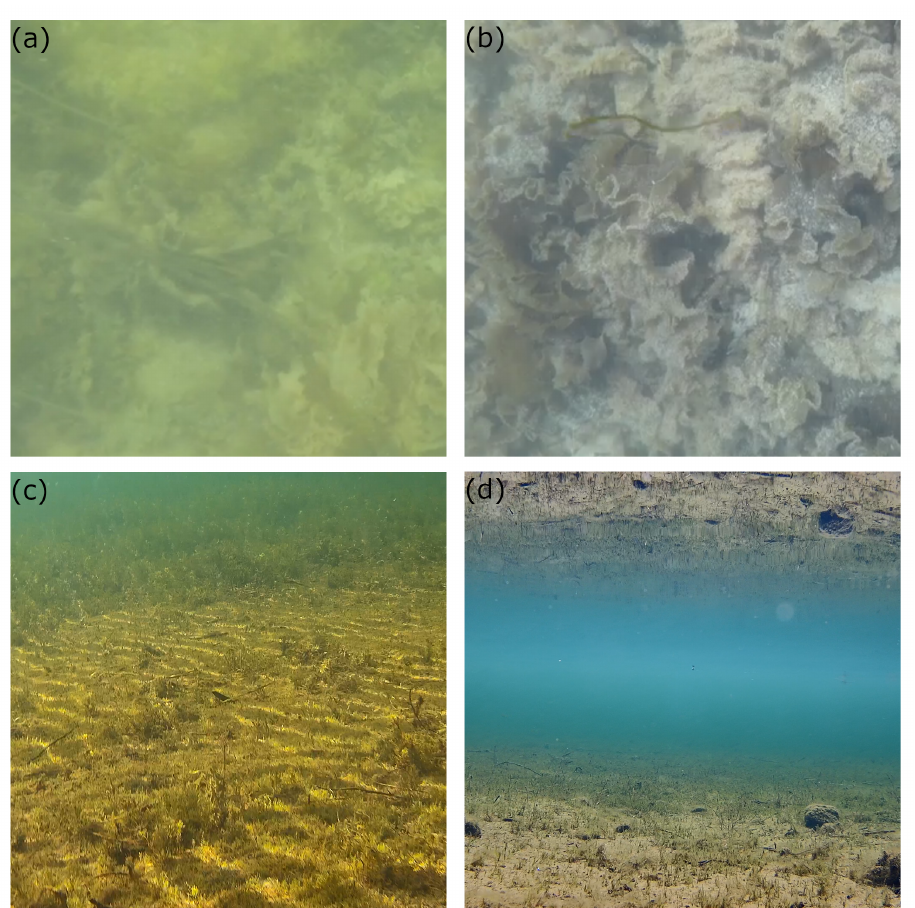
Figure 12. RoboFish Computer Vision Challenges: ( a ) almost completely green image showing limited visibility, ( b ) floating particles in the foreground, ( c ) water caustics on a lake bed, created by the surface of the water, and ( d ) total internal reflection underwater causing a mirror image of a lake bed in the water